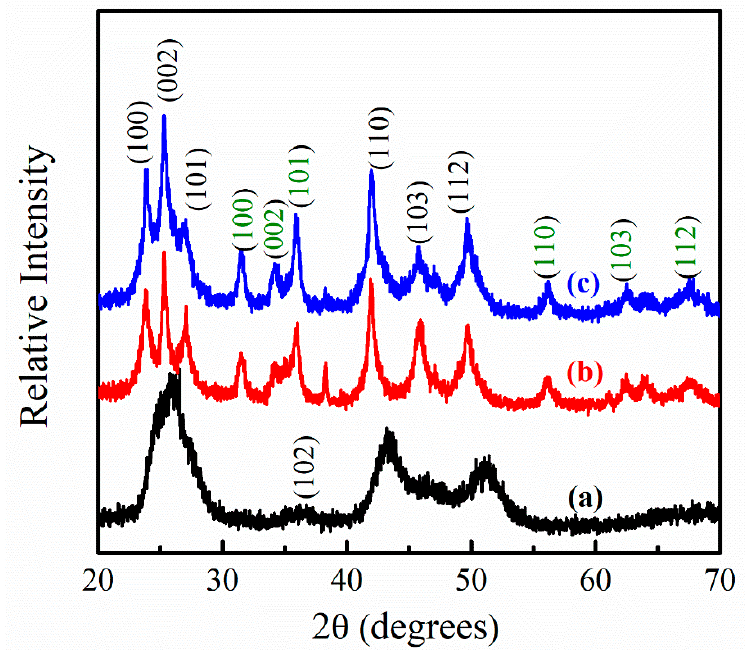
Figure 4. Effect of the high OLA content on the XRD patterns of ( a ) pure Zn 0.5 Cd 0.5 Se, ( b ) Zn 0.5 Cd 0.5 Se-6, and ( c ) Zn 0.5 Cd 0.5 Se-10 alloy QDs.